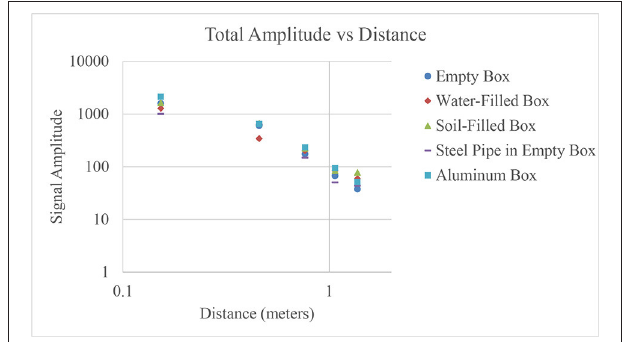
FIGURE 6 | Combined (X, Y, Z) strength of primary frequency feature vs. distance, with rotating magnet source at